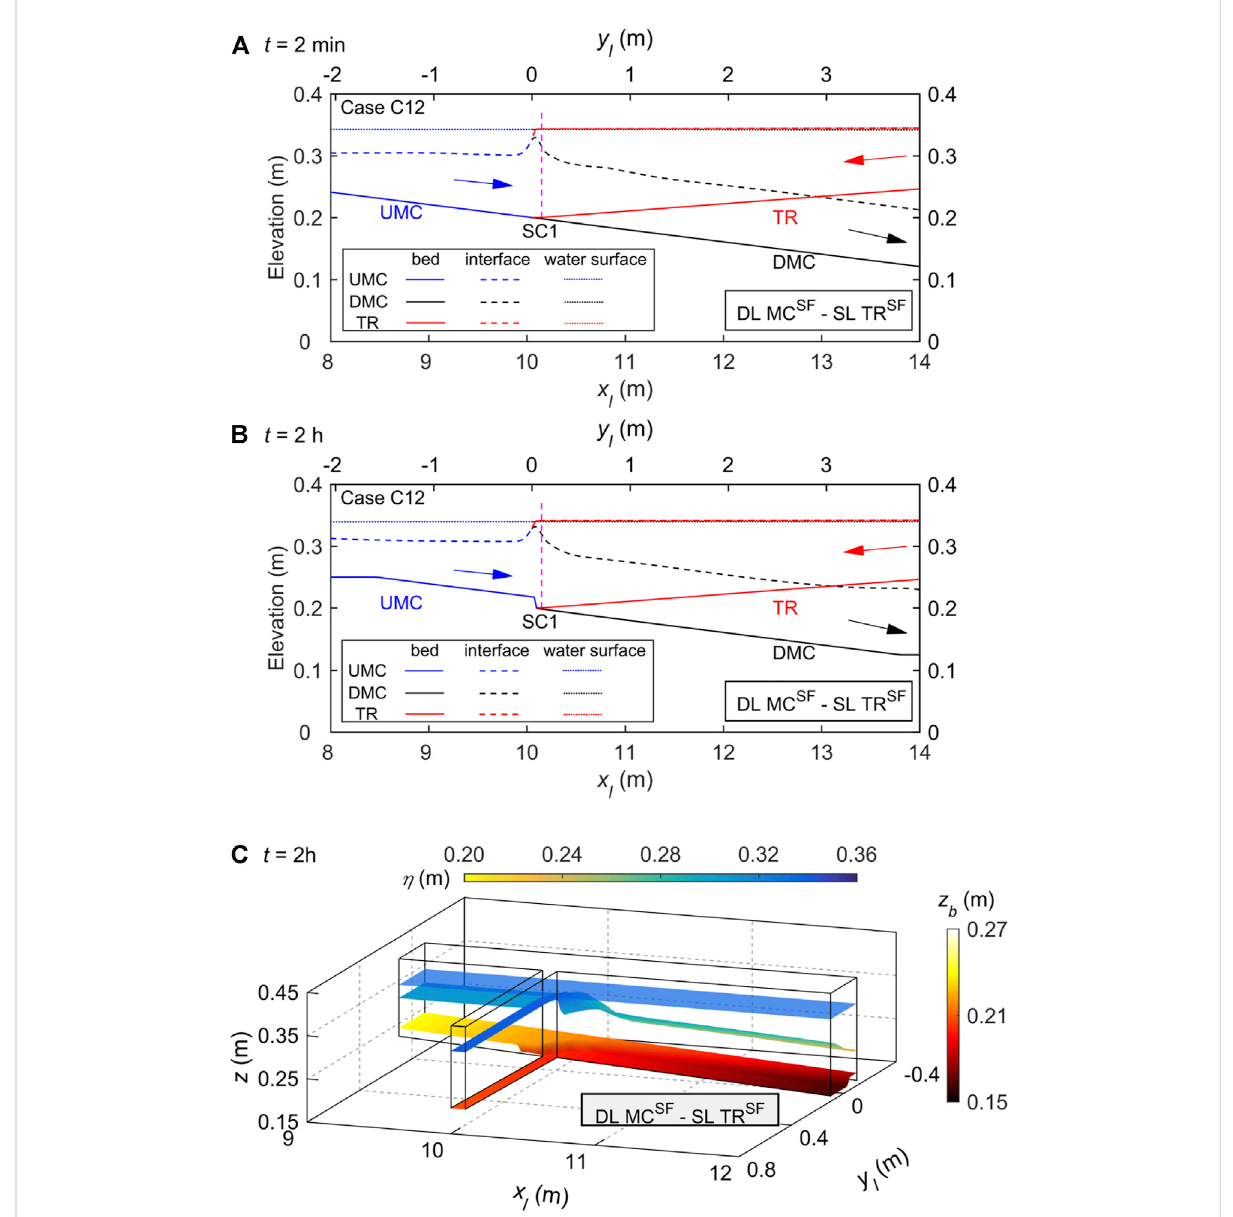
Case C12 of DL MC SF — SL TR SF for high-concentration sediment-laden fl ow in the main channel (MC) and low-concentration sediment-laden fl owinthetributary(TR),whereUMCandDMCdenoteupstreamanddownstreamoftheMCcon fl uence:freewatersurfaceelevation,interface,and bed elevation pro fi les along the central axes of the main channel and tributary at (A) a stable state ( t = 2 min), (B) a long-term state ( t = 2 h); and (C) three-dimensional layered fl ow structure at t = 2